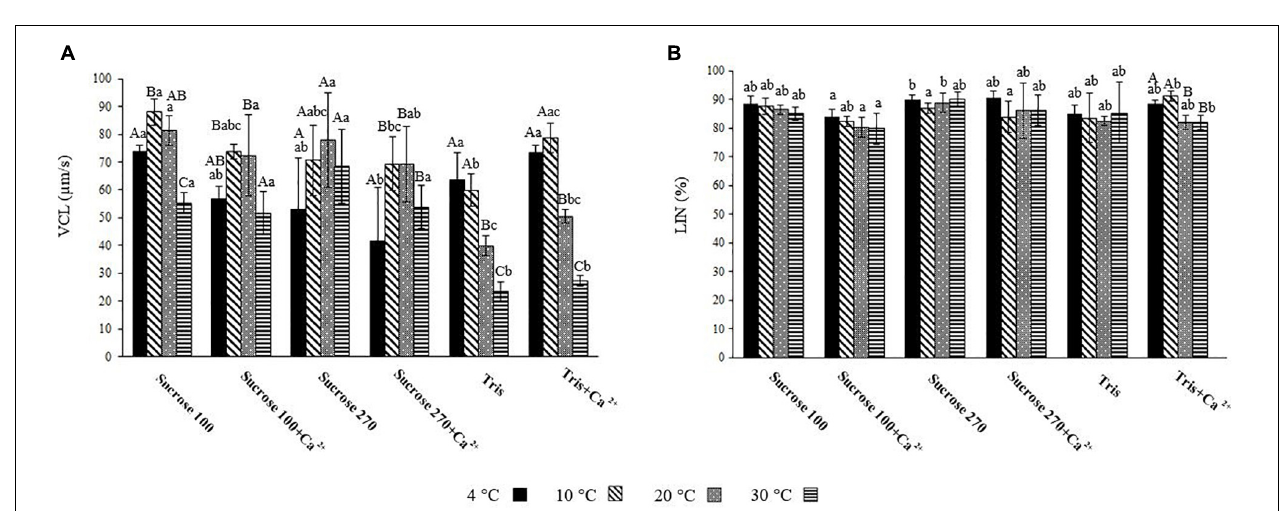
FIGURE 2 | Linearity (LIN) of L. lota spermatozoa in relation to time post-activation (up to 60 s) at 4, 10, 20, and 30 ◦ C in Tris, Tris + Ca 2 + ; Suc 100, Suc 100 + Ca 2 + , Suc 270, and Suc 270 + Ca 2 + .